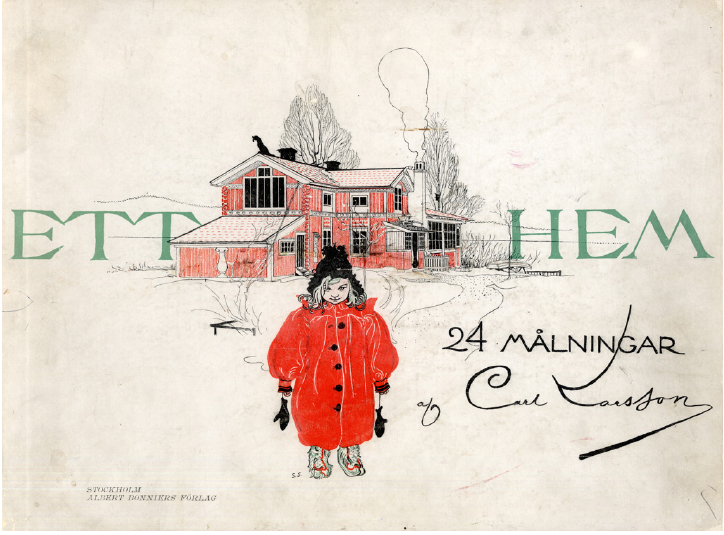
Figure 8. Carl Larsson (1853–1919): Ett hem (“ A Home ”), Stockholm, Albert Bonniers Forlag, 1899, cover.